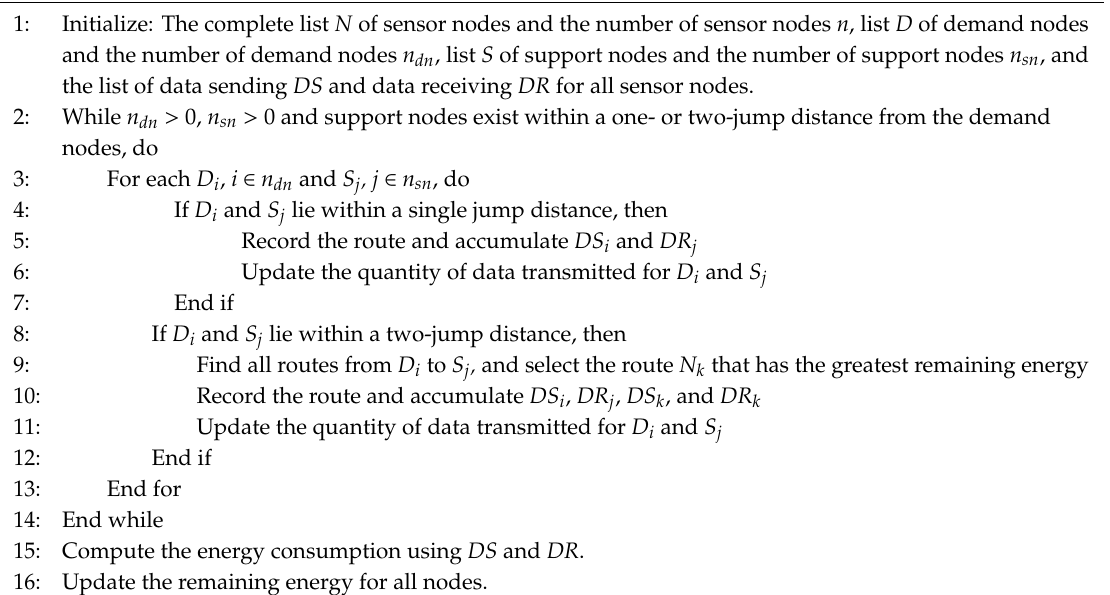
Algorithm 1. Unit Data Polling Scheduling and the Maximum Remaining Energy Routing Algorithm.